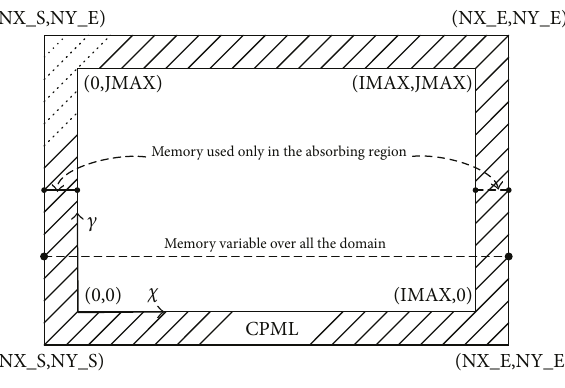
Figure 2: CPML ABC implementation options.